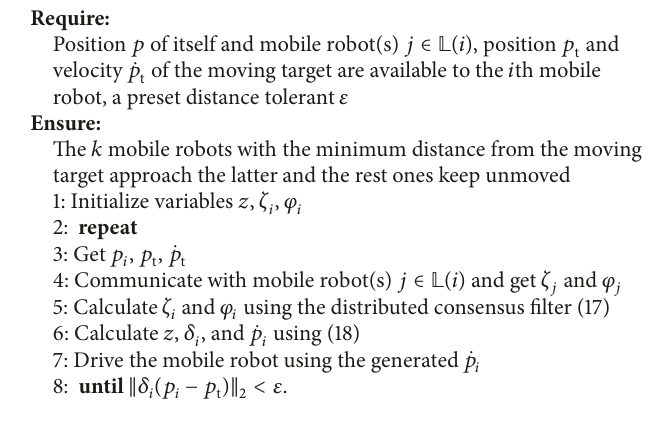
Algorithm 2: Distributed competitive target tracking control for the 𝑖 th mobile robot with limited communication.